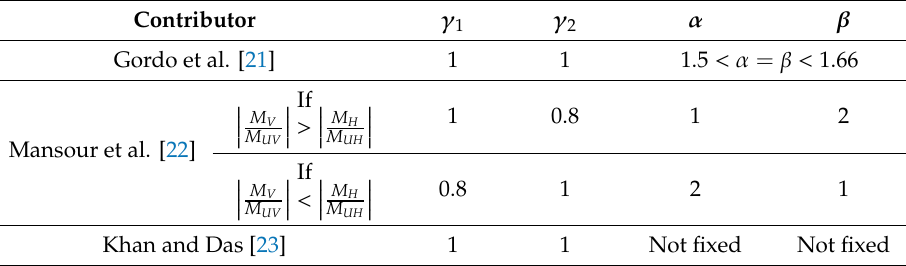
Table 1. Fitting parameters used by researchers for intact ships.